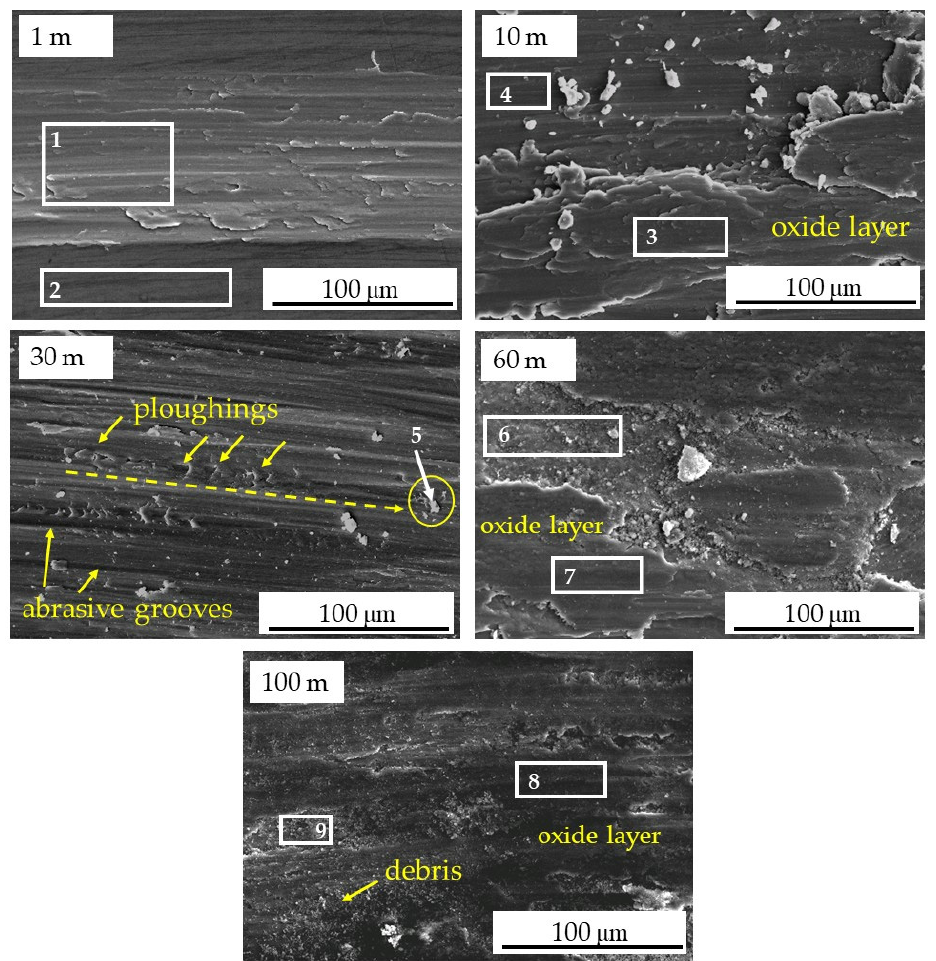
Figure 9. SEM images of the worn track at various sliding distances.